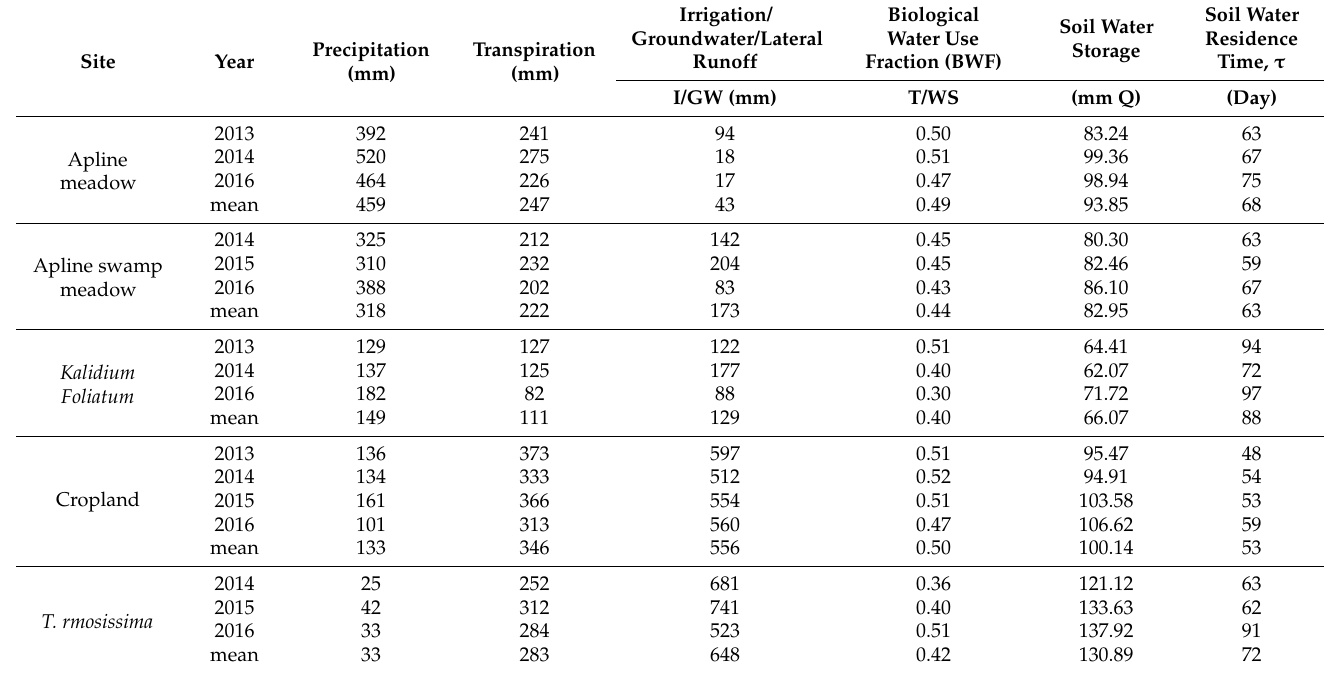
Table 4. Fraction of biological water use and residence time of soil water in ecosystems in Heihe River